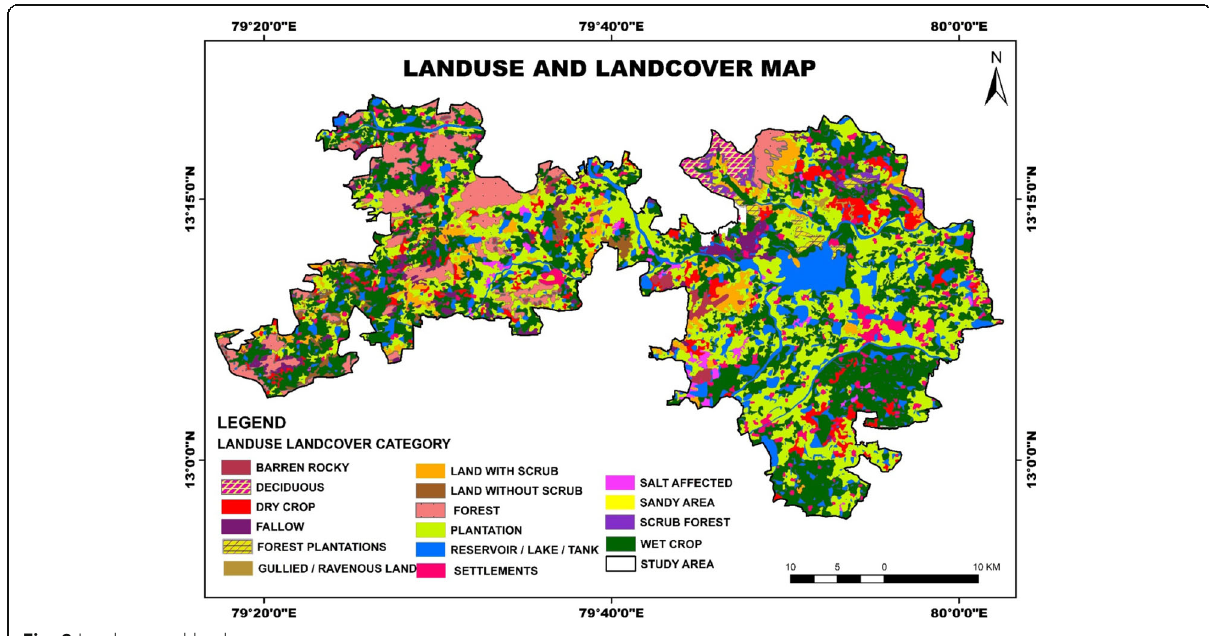
Fig. 8 Land use and landcover map